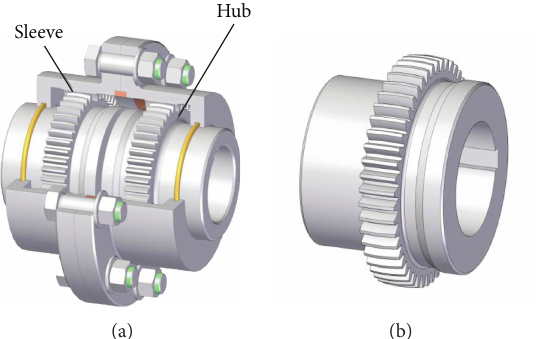
Figure 1: Gear coupling (a) and hub with crowned teeth (b).